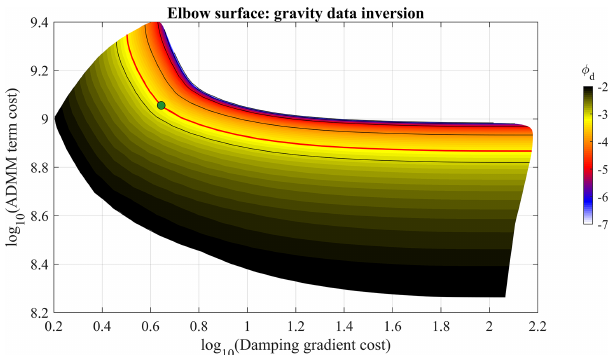
Figure 15. Elbow surfaces for gravity inversions. A total of 840 points sampling the (α g ,α a ) plane were used. The black lines show the contour values corresponding to the ticks shown in the palette’s colour bar, which shows the value of the data misfit term. The red = 5 . 008 × 10 − 4 , guiding line indicates the contour value of (cid:50) obj d the selection of the optimum ( α g ,α g ) values, and the green point indicates the curve inflection